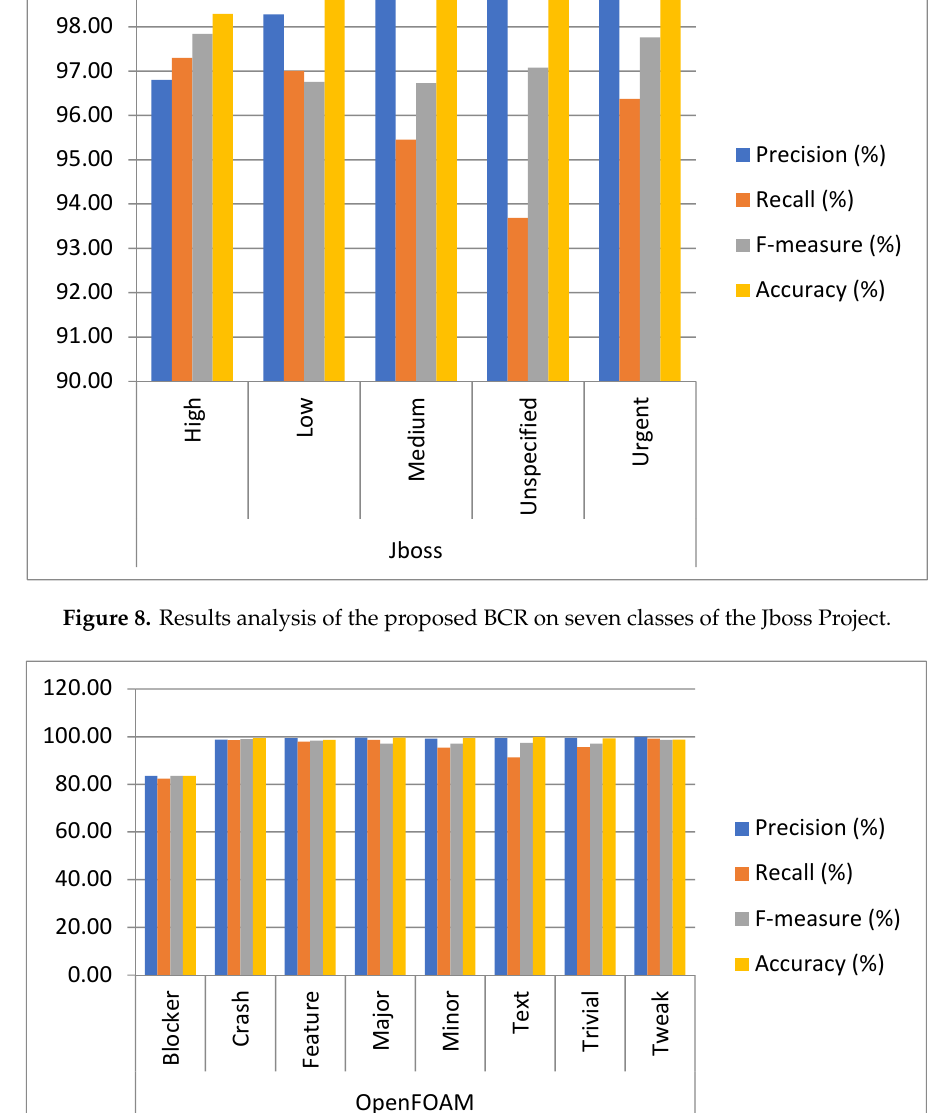
Figure 9. Result analysis of the proposed BCR on seven classes of the OpenFOAM Project .